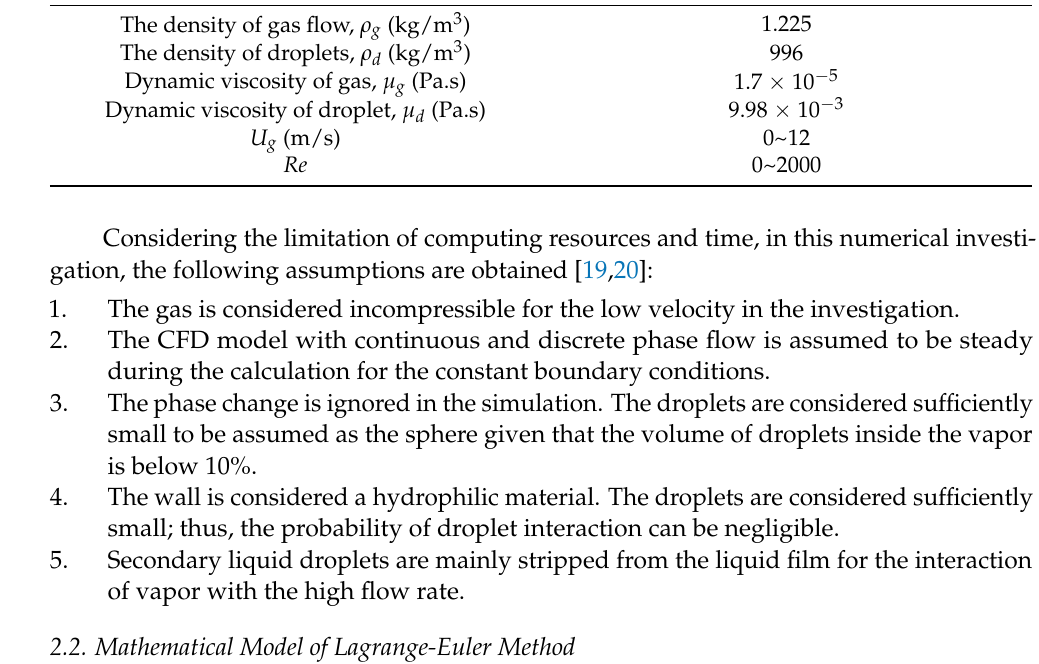
Figure 3. Boundary conditions of the curved vane demister’s unit of case L2 . Table 3. Hydrodynamic and heat transfer conditions of the two-phase flow.